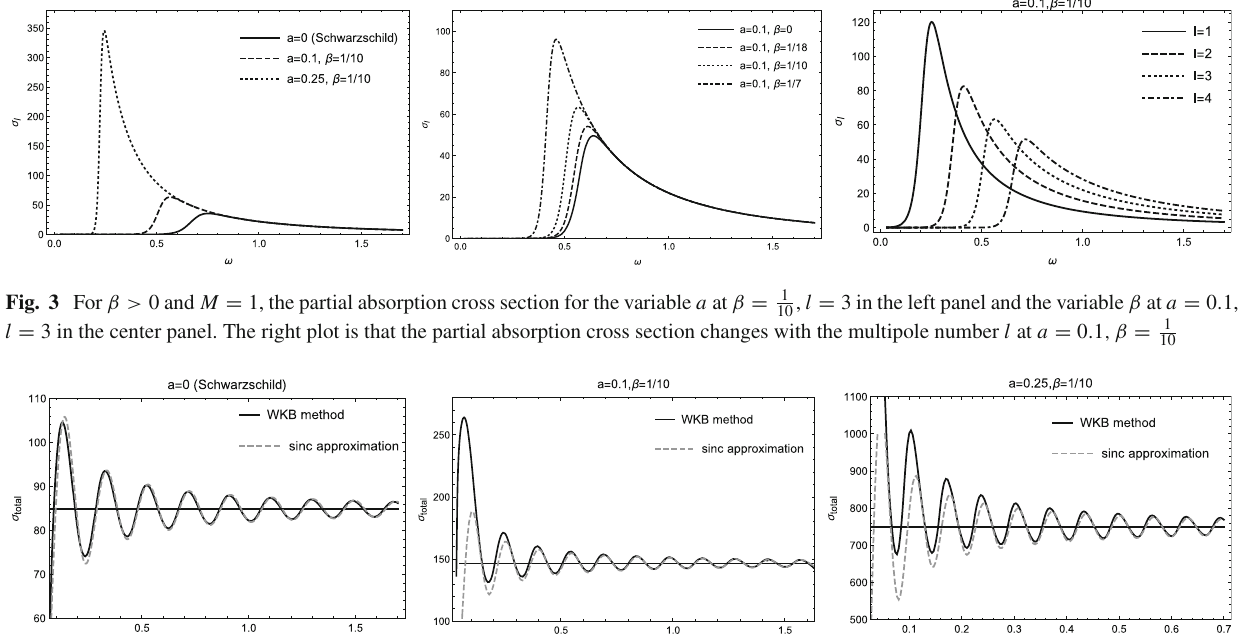
, a = 0 recovers to the Schwarzschild black hole 10